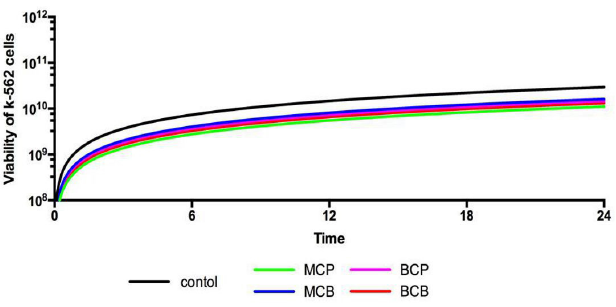
FIGURE 5 – Cell viability vs . time, for different treatments.